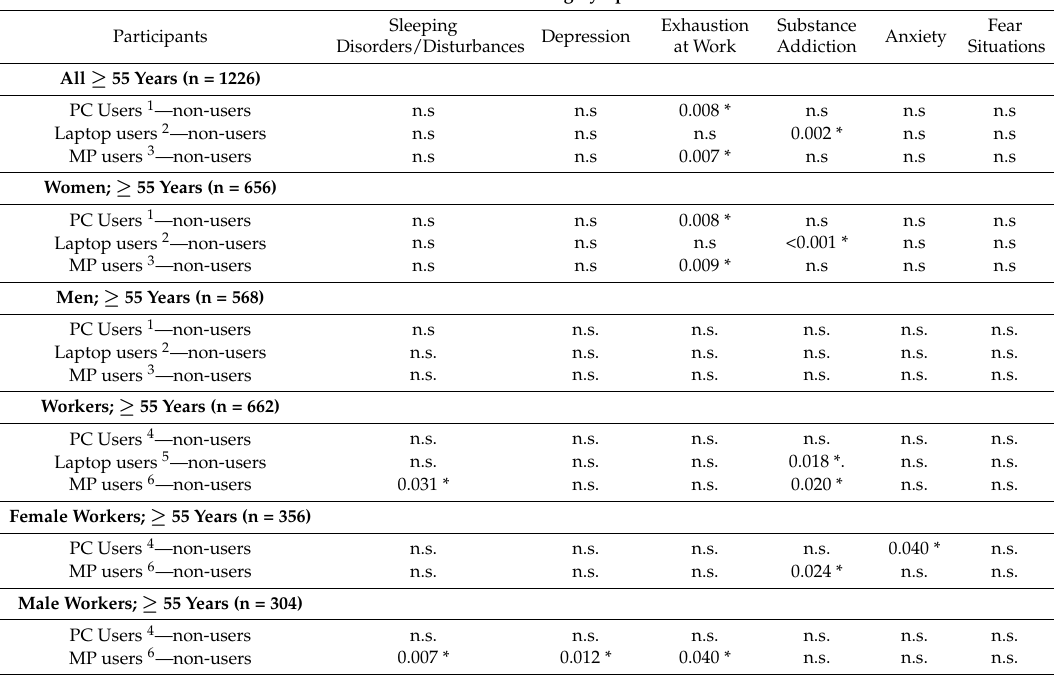
Table 4. The results of the ≥ 55-year-old persons using Mann-Whitney U-Test for Question 16. The comparisons are the following: (1) persons who used a desktop computer daily at leisure and non-users, (2) daily users of laptops and non-users, (3) daily users of the mobile phone and non-users. This table also includes the same comparisons for women and men and workers, and comparison 1 and 3 for female workers and male